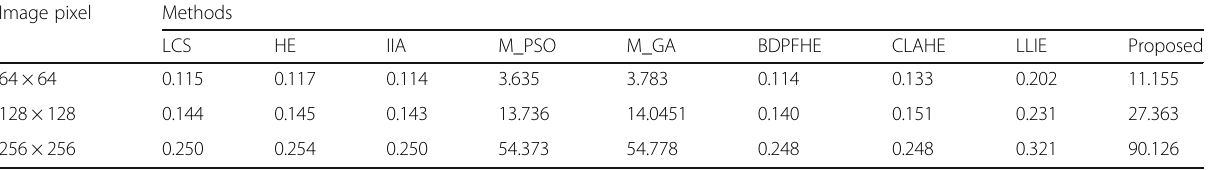
Table 10 Processing time per facial image comparison using the different image enhancement methods on different image pixel size Image